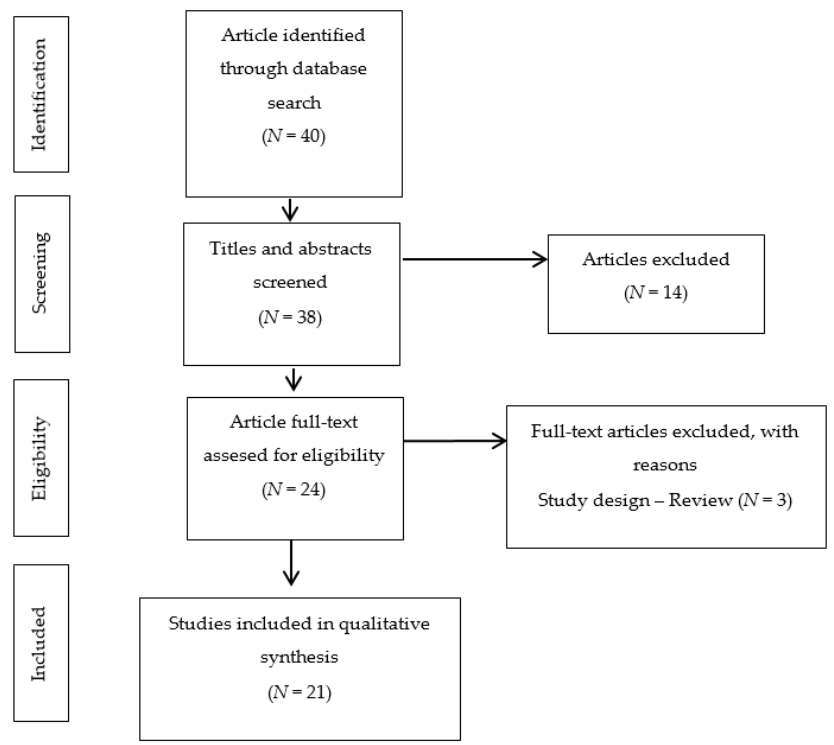
Figure 1. Flow diagram of the search process according to PRISMA-ScR. PRISMA Extension for Scoping Reviews.